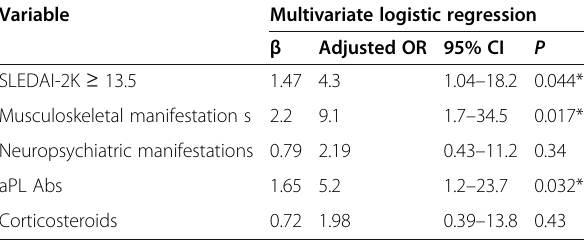
Table 4 Binary logistic regression analysis for the predictors